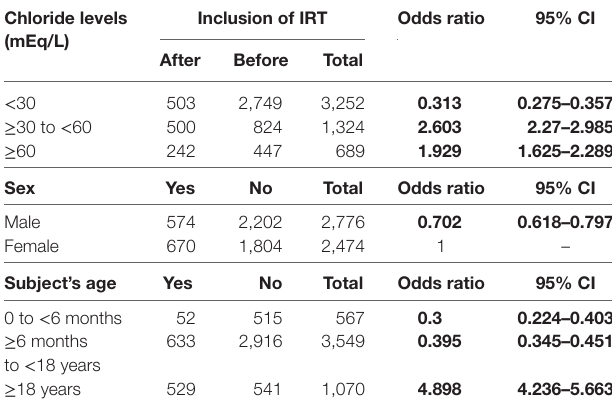
Table 5 | Distribution of patients for the CFTR gene genotype and classes of identified mutations*.